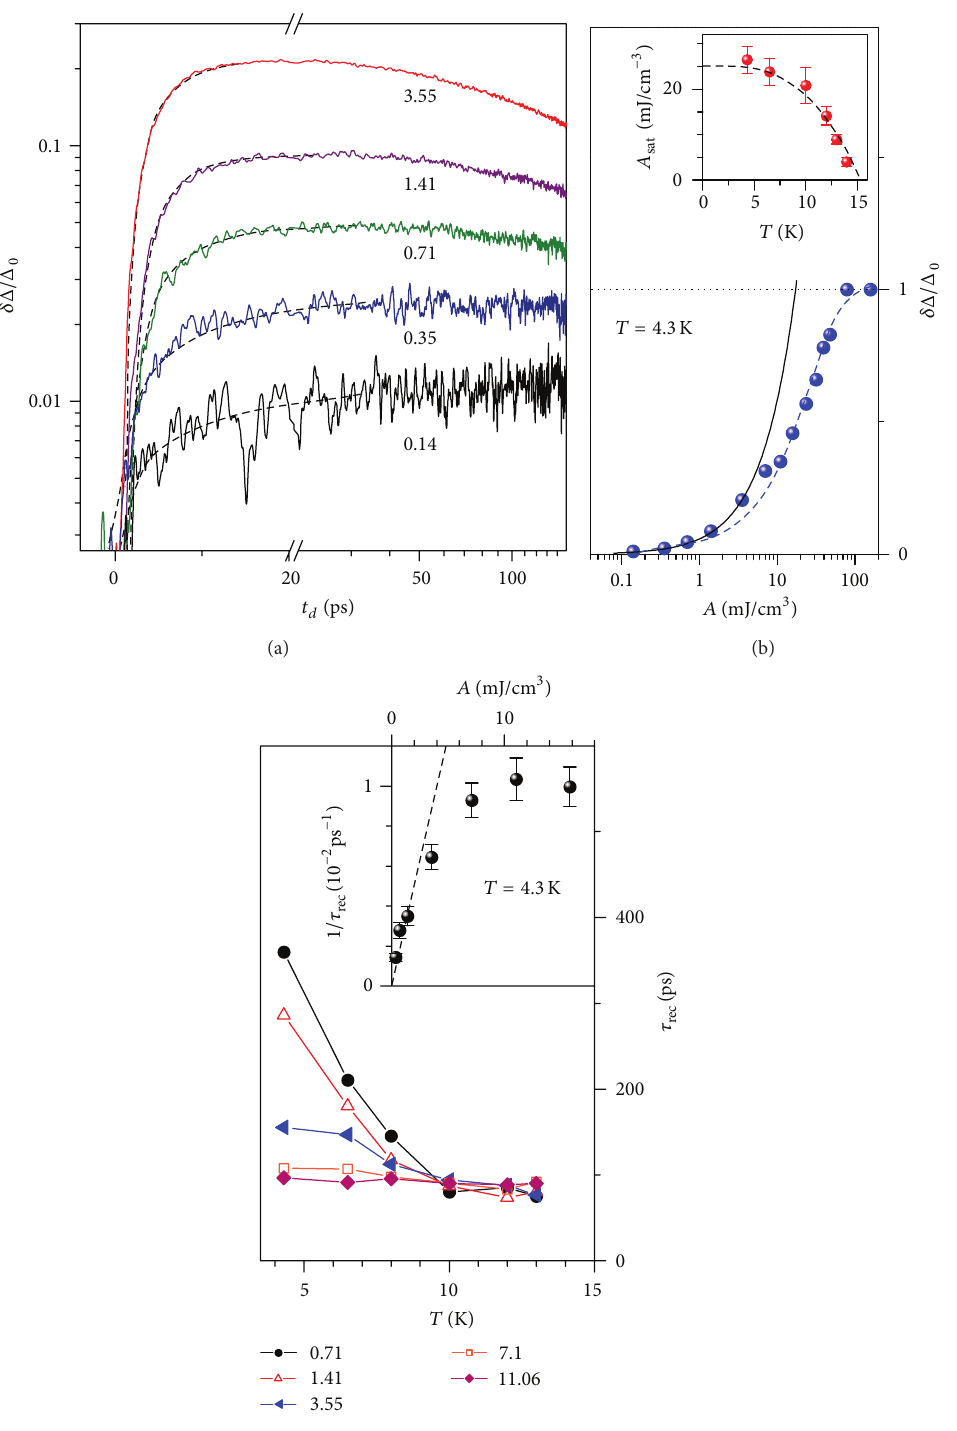
Figure 19: (a) The relative change in gap, 𝛿Δ/Δ 0 recorded at 4.3 K for various intensities A in mJ/cm 3 . The dashed lines are fits to the data with (1). (b) The dependence of 𝛿Δ/Δ 0 on intensity A at 4.3 K. The dashed line is a fit to the simple saturation model; the solid line is the linear fit. Inset: the temperature dependence of the saturation energy density, 𝐴 sat , compared to the 𝑇 -dependence of Δ 2 (dashed line). Panel (𝐴) recorded at 4.3K. , for several intensities 𝐴 (in mJ/cm 3 ). Inset: 𝜏 −1 (c) shows the 𝑇 -dependence of the superconducting recovery time, 𝜏 rec rec For low intensities 𝐴 the relaxation rate increases linearly with 𝐴 (dashed line) (after